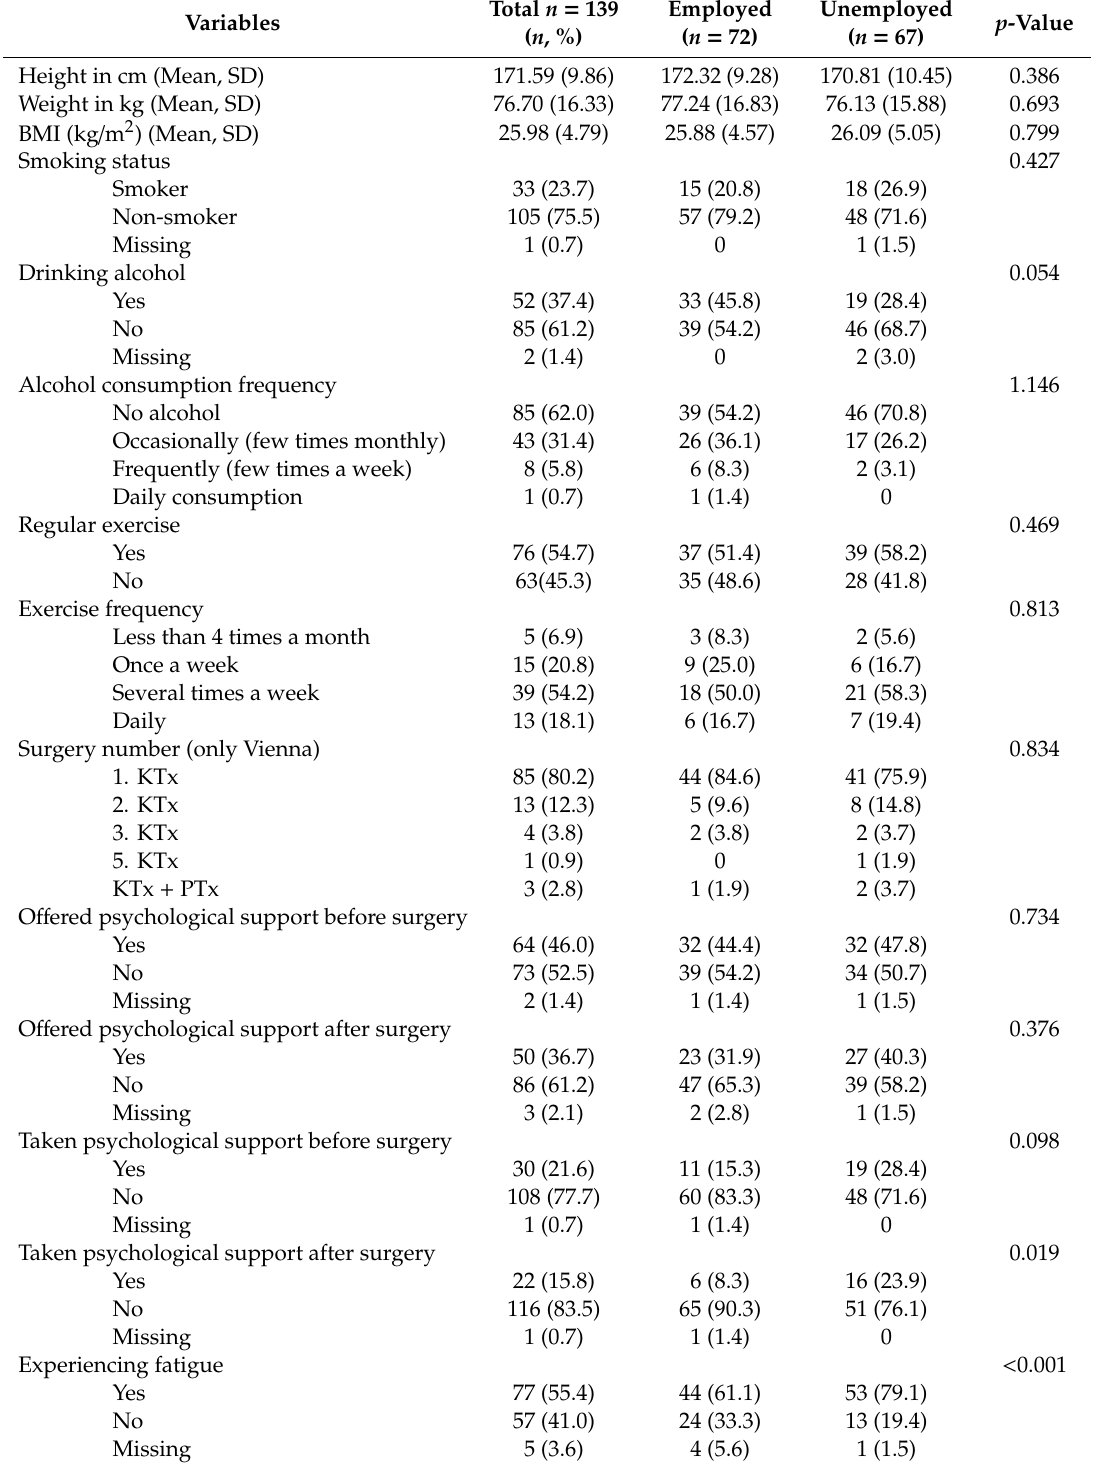
Table 2. Health-related outcomes. Analysis of health data in all participants and stratified by current employment status. Total n = 139 Employed Unemployed p -Value Variables ( n , %) ( n = 72) ( n = 67) Height in cm (Mean, SD) 171.59 (9.86) 172.32 (9.28) 170.81 (10.45) 0.386 Weight in kg (Mean, SD) 76.70 (16.33) 77.24 (16.83) 76.13 (15.88) 0.693 BMI (kg / m 2 ) (Mean,